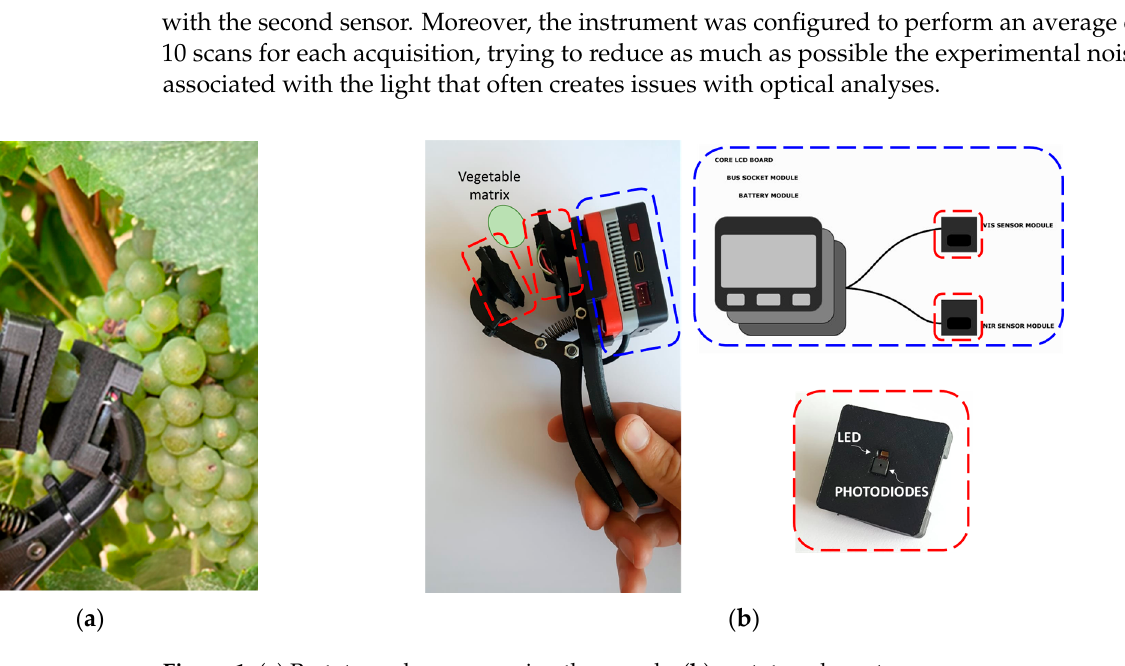
Figure 1. ( a ) Prototype clamp wrapping the sample; ( b ) prototype layout.